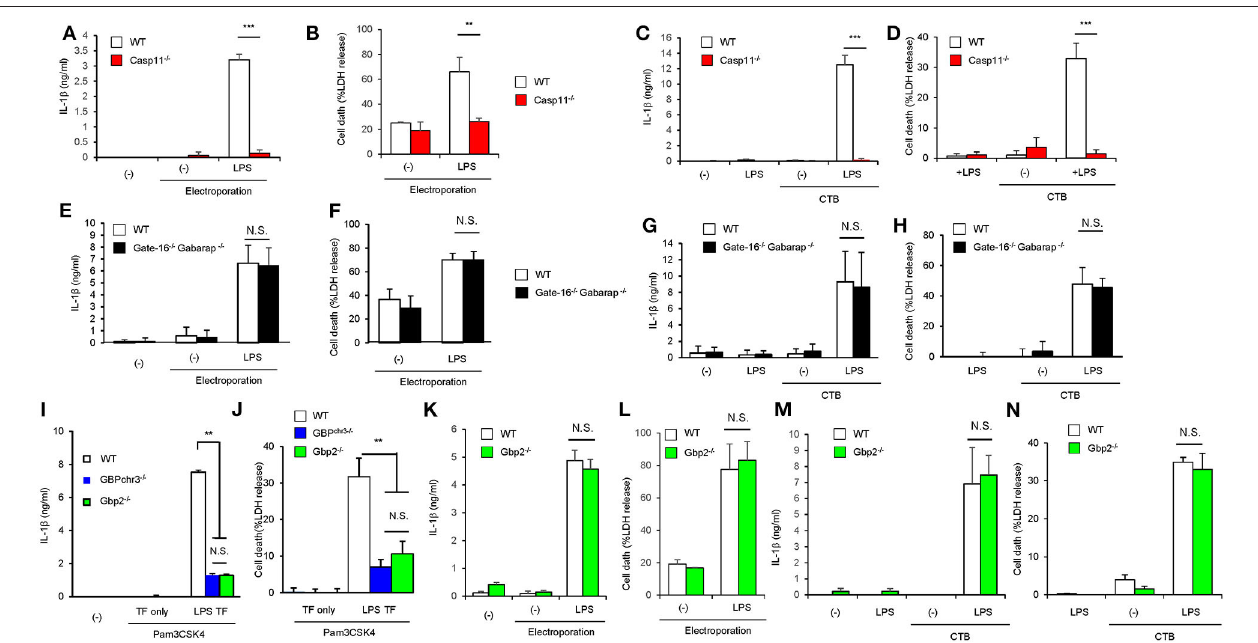
FIGURE 4 | Enhanced activation of caspase-11 inflammasome in Gate-16 − / − Gabarap − / − macrophages is associated with the GBP2 dependency. (A,B) Release of IL-1 β (A) and LDH (B) from Pam3CSK4-primed wild-type (WT) or Casp11 − / − BMDMs were electroporated with LPS and collected after 16h. (C,D) Release of IL-1 β (C) and LDH (D) from Pam3CSK4-primed wild-type (WT) and Casp11 − / − BMDMs were treated with LPS and CTB (LPS + CTB) for 16h. (E,F) Release of IL-1 β (E) and LDH (F) from Pam3CSK4-primed wild-type (WT) and Gate-16 − / − Gabarap − / − BMDMs were electroporated with LPS and collected after 16h. (G,H) Release of IL-1 β (G) and LDH (H) from Pam3CSK4-primed wild-type (WT) and Gate-16 − / − Gabarap − / − BMDMs were treated with LPS + CTB for 16h. (I,J) Release of IL-1 β (B) or LDH (C) from wild-type (WT), GBPchr3 − / − , and Gbp2 − / − BMDMs primed with Pam3CSK4 followed by LPS transfection for 16h. (K,L) Release of IL-1 β (K) and LDH (L) from Pam3CSK4-primed wild-type (WT) and Gbp2 − / − BMDMs were electroporated with LPS and collected after 16h. (M,N) Release of IL-1 β (M) and LDH (N) from Pam3CSK4-primed wild-type (WT) and Gbp2 − / − BMDMs were electroporated with LPS and collected after 16h. The data are combined data of more than three independent experiments (A–N) . ** P < 0.01, *** P < 0.001, and N.S., not significant, two-tailed Student t